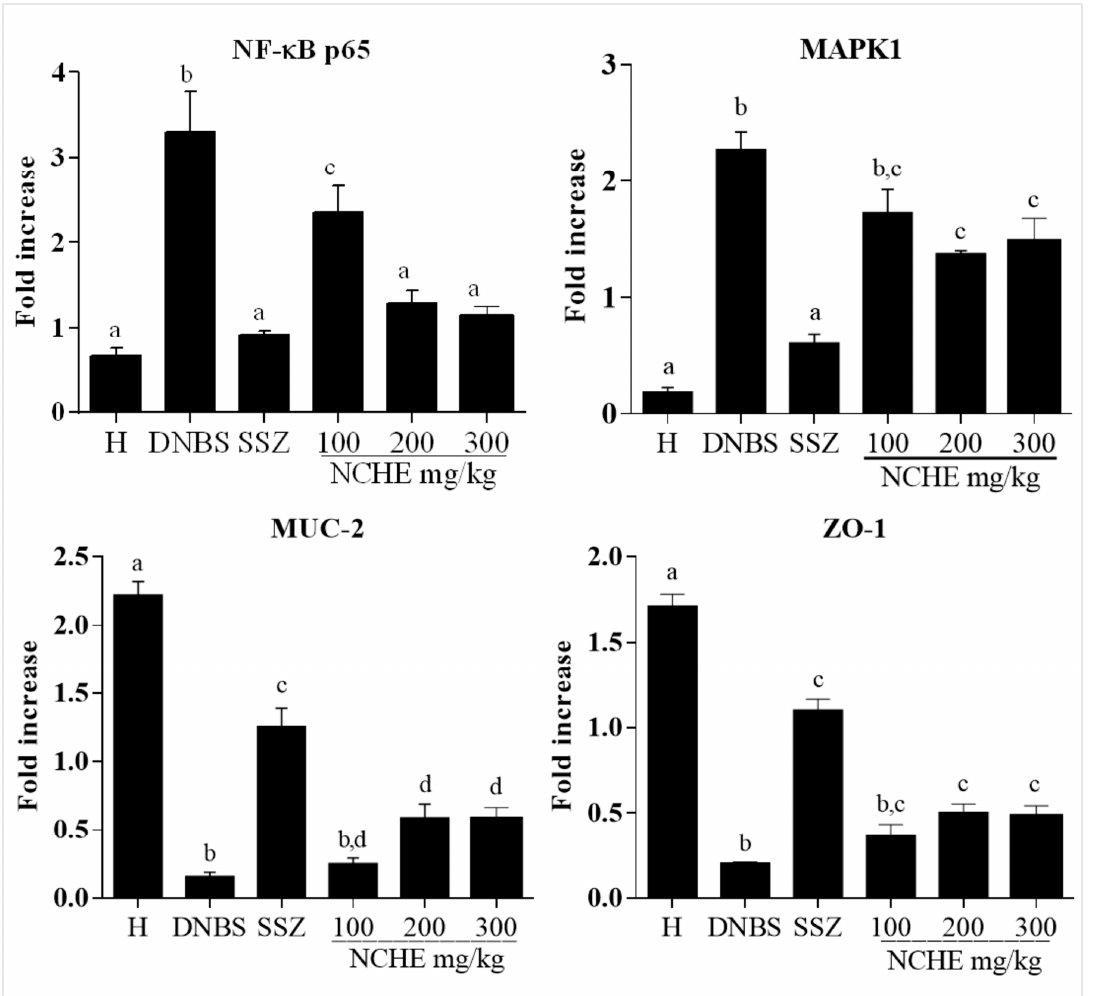
Figure 6. Effect of N. cochenillifera hydroethanolic extract (NCHE) (100, 200 and 300 mg/kg) and sulfasalazine (SSZ) (250 mg/kg) on the gene expression of mitogen-activated protein kinase 1 (MAPK1/ERK2), nuclear factor kappa B p65 (NF- κ B p65), zonula occludens type I (ZO-1) and mucin type II (MUC-2) in colonic tissue of the experimental trial of acute colitis induced by 2,4- dinitrobenzene sulfonic acid (DNBS) in rats. Healthy group. Data are expressed as means ± SEM. Groups with a different letter differ statistically ( p < 0.05).